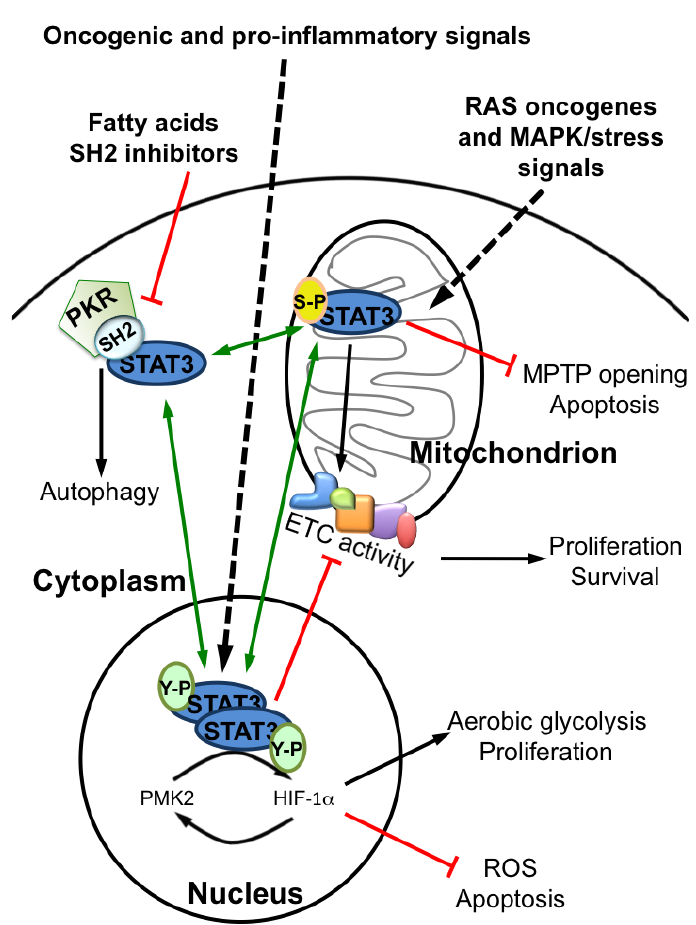
Figure 6. STAT3 can be localized in the mitochondrial matrix, in the nucleus and in the cytoplasm, according to specific post-transcriptional modifications triggered by different upstream stimuli. Many oncogenic and inflammatory signals mainly induce Y-P STAT3 nuclear functions that, in addition to known canonical functions, mediate the induction of Hif -1 α and lead to increased glycolysis and to the initiation of a positive feedback between HIF-1 α , PKM2 and STAT3. This contributes to supporting cell proliferation and protection from apoptosis and senescence. On the other hand, nuclear Y-P STAT3 reduces mitochondrial activity by down-regulating, directly or indirectly, many ETC complexes mRNAs, leading to reduced mitochondrial respiration, ROS production and apoptosis. In contrast, RAS oncogenic signals and MAP kinases trigger S-P and mitochondrial STAT3 functions, improving cell survival by enhancing both oxidative phosphorylation and aerobic glycolysis, and protecting cells from apoptosis by inhibiting the opening of the mitochondrial permeability transition pore (MPTP). Finally, cytoplasmic STAT3 can inhibit autophagy by interacting with the cytoplasmic Protein Kinase R (PKR) via its SH2 domain. The relative abundance of each form of STAT3 is the result of a balance with the other forms, in turn determined by the interplay of different activating and inactivating signals. Black arrows: induction; green arrows: interplay; red lines: